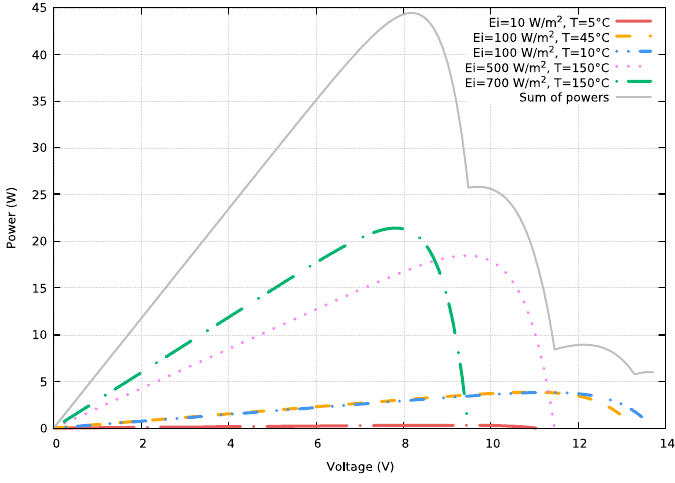
Figure 1. Sum of powers.